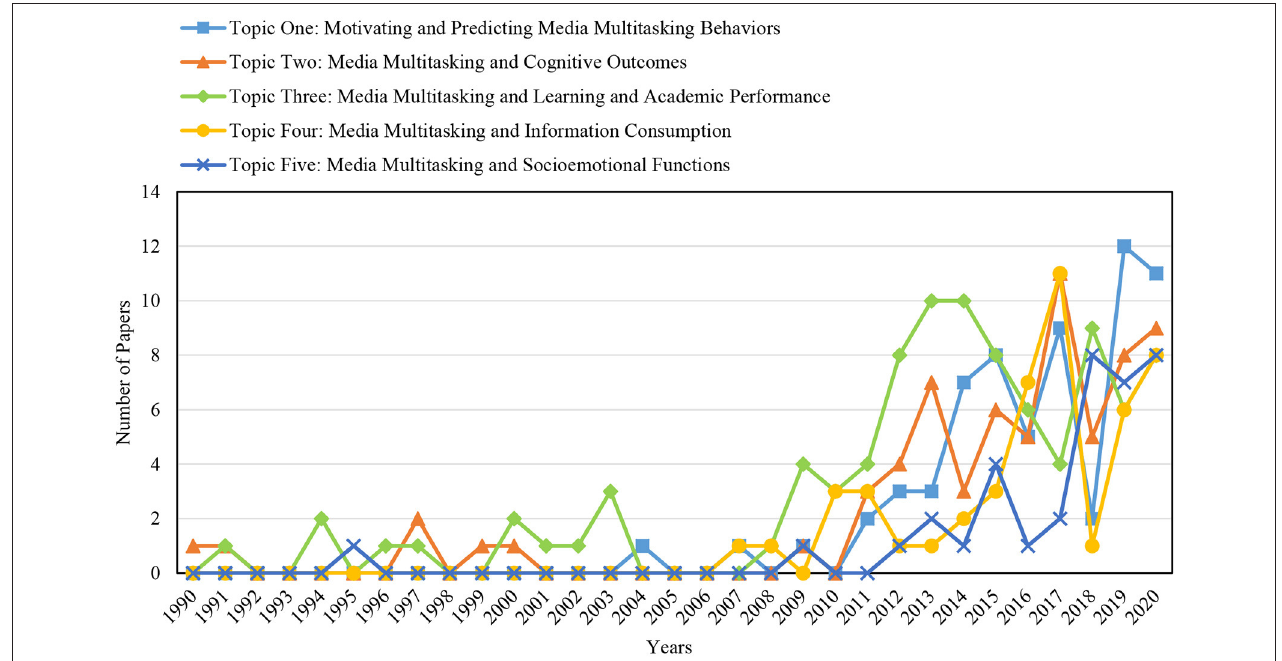
FIGURE 4 | The evolution of research groups over